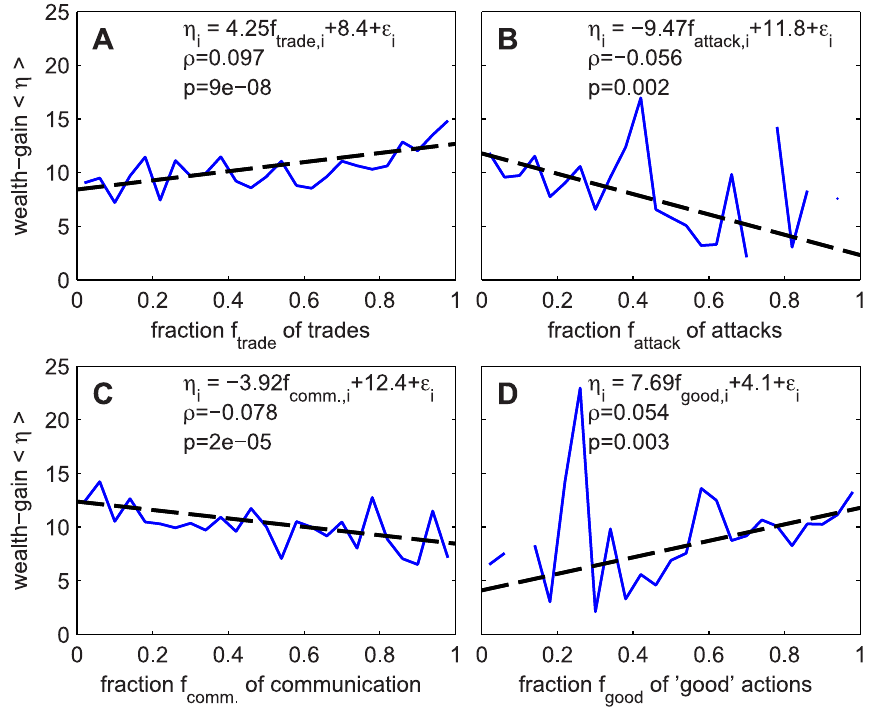
Figure 5. Wealth-gain as a function of behavior. Behavior is quantified as the fraction of particular actions, such as A trades, B attacks, and C communication, with respect to all actions performed by an individual. The blue line shows binned averages, the dashed line is the linear regression. Data consist of all actions between day 1170 and 1200 and wealth-gain on day 1200.